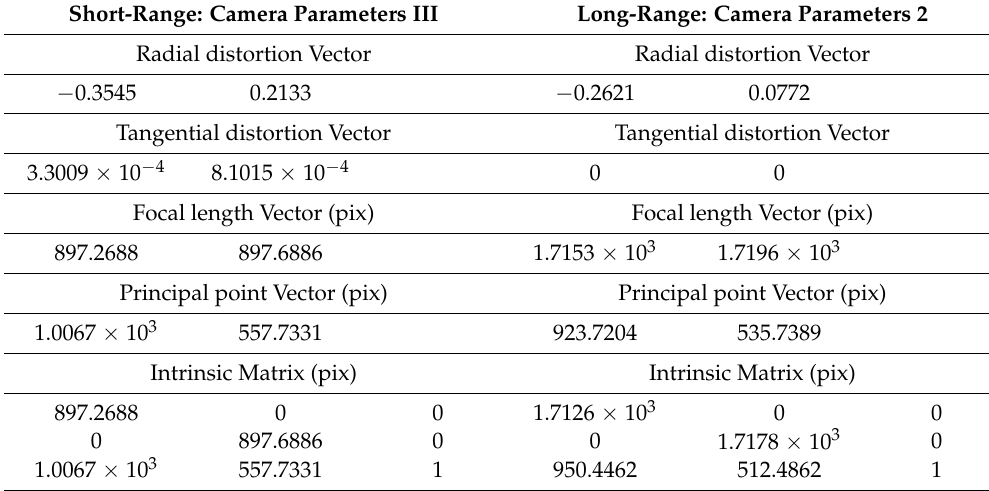
Table A2. Values of the calibration of the right camera for both measuring ranges.